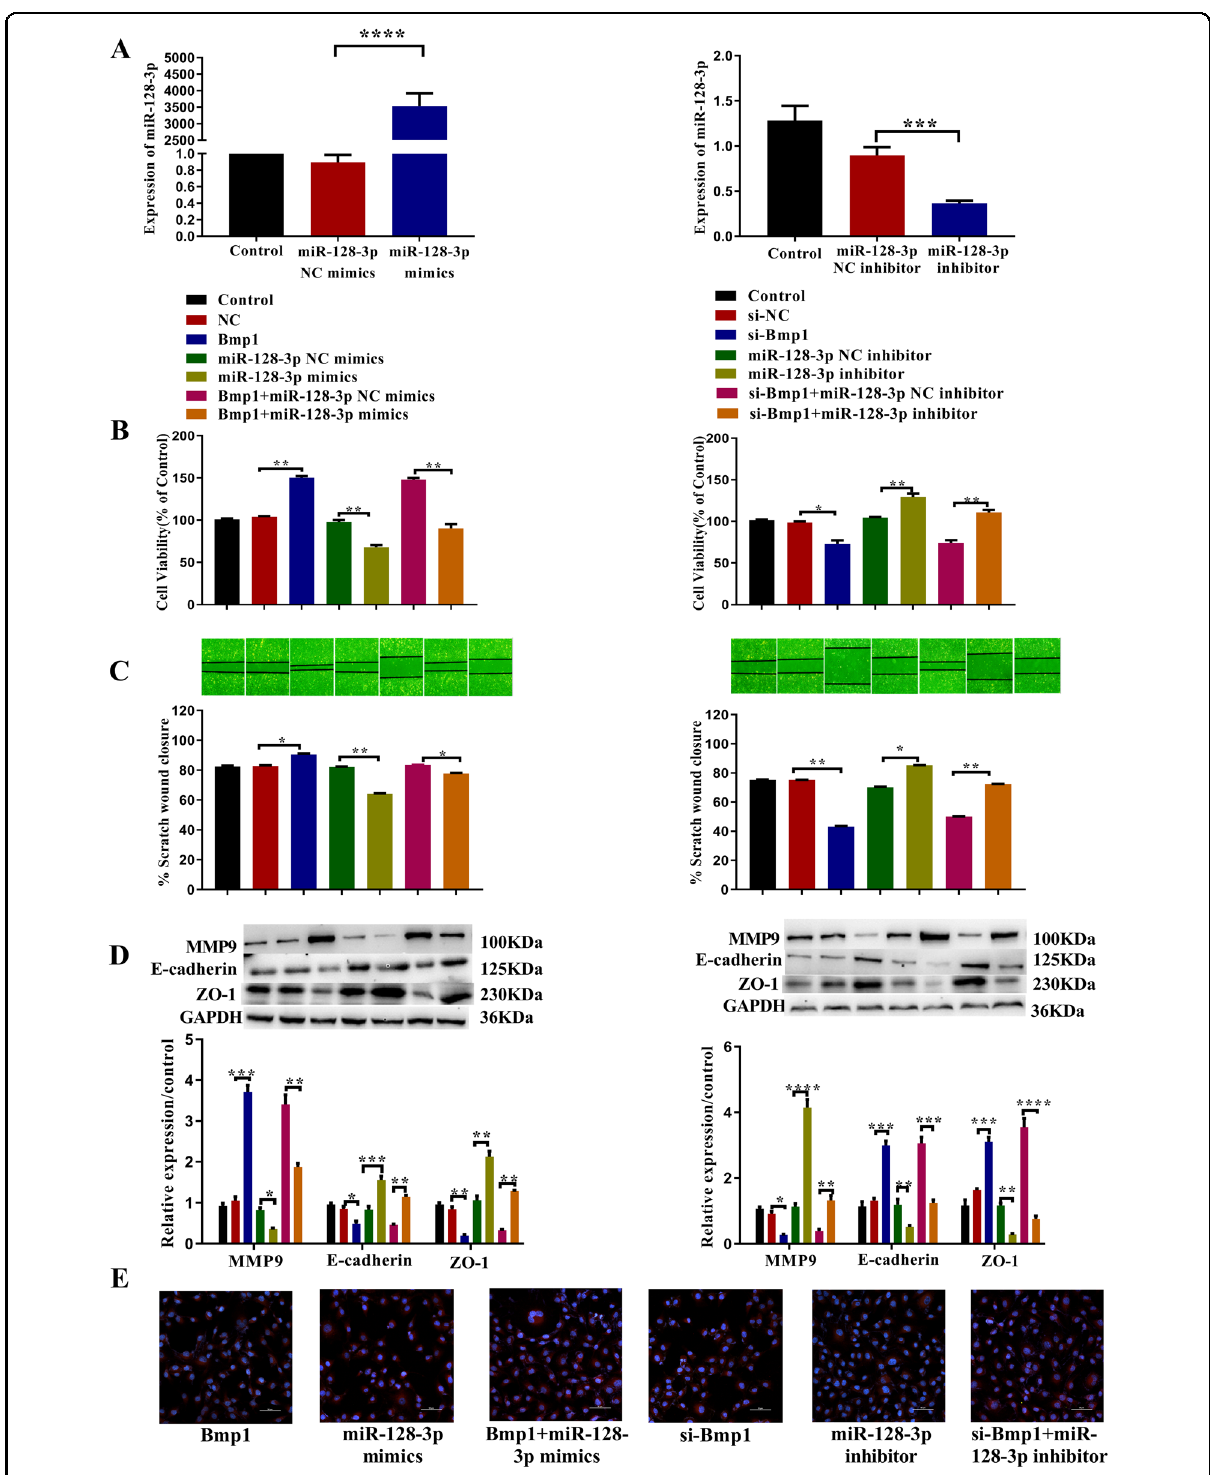
Fig. 5 MiR-128-3p mimic can rescue the impacts of overexpression of bmp1 on IEC-6 cells. A The expression of miR-128-3p in IEC-6 cells transfected with miR-128-3p mimic or miR-128-3p inhibitor were determined using qRT-PCR ( n = 3). B Cell viability ( n = 3), C cell migration ability ( n = 3), D E-cadherin and ZO-1 were analyzed using cell counting kit-8 assay, wound healing assay and western blot, respectively ( n = 3). E Representative immuno fl uorescence analysis showed the content of E-cadherin in treated IEC-6 cells ( n = 3). All data were demonstrated as mean ± SD from three independent experiments performed in duplicate. * p < .05, ** p < .01, *** p < .001 and **** p < .0001 were all signi fi cant